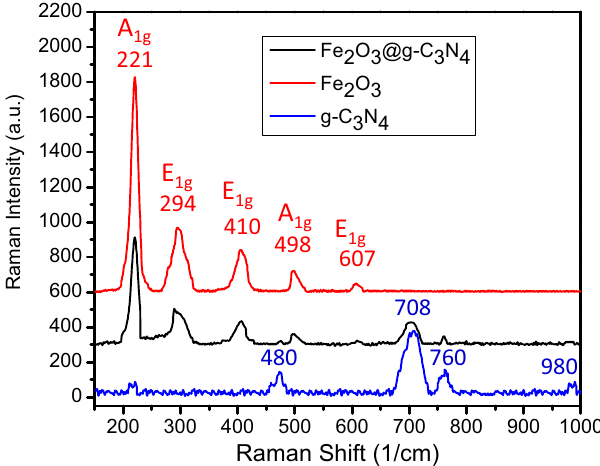
Figure 4. Raman spectra of g-C 3 N 4 , mesoporous α -Fe 2 O 3 @g-C 3 N 4 -NCs and α -Fe 2 O 3 -NPs.